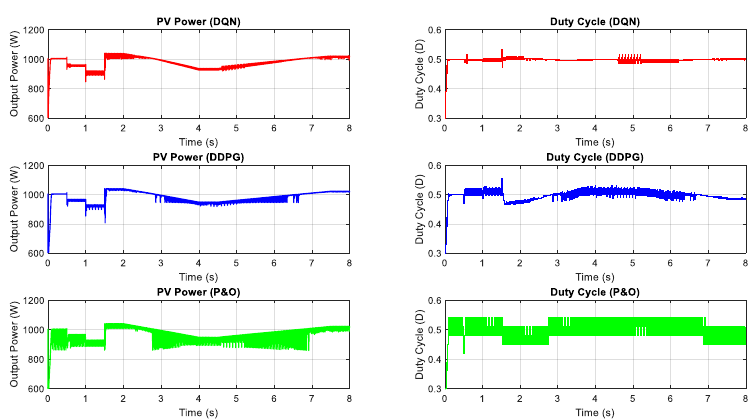
Figure 10. PV power under the change of temperature.